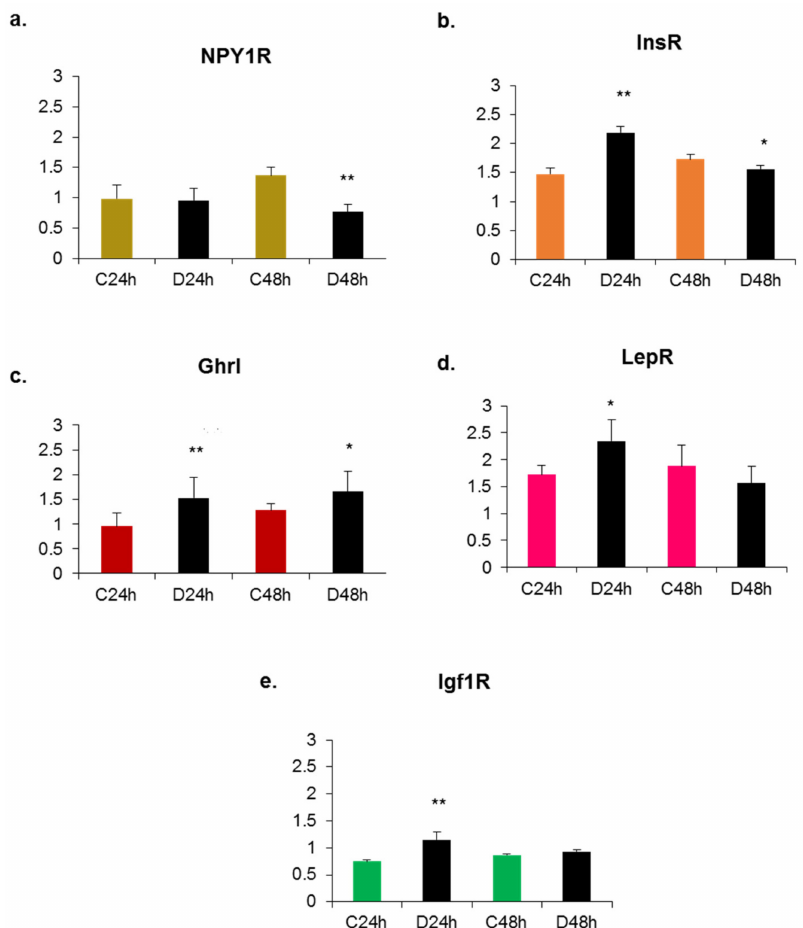
Figure 2. E ff ects of methyl donor deficiency on mRNA expression of neuropeptides and receptors in the rat cell line (rHypoE11) at 24 and 48 h of growth. Data are means ± SD from 6 ≤ n ≤ 8 samples and are reported in arbitrary units. Statistically significant di ff erences between control (C) and B9 deficient (D) cells: * p < 0.05 and ** p < 0.01. ( a ) Neuropeptide Y receptor 1 (NPY1R); ( b ) insulin receptor (InsR); ( c ) ghrelin (Ghrl); ( d ) leptin receptor (LepR); ( e ) insulin growth factor receptor 1